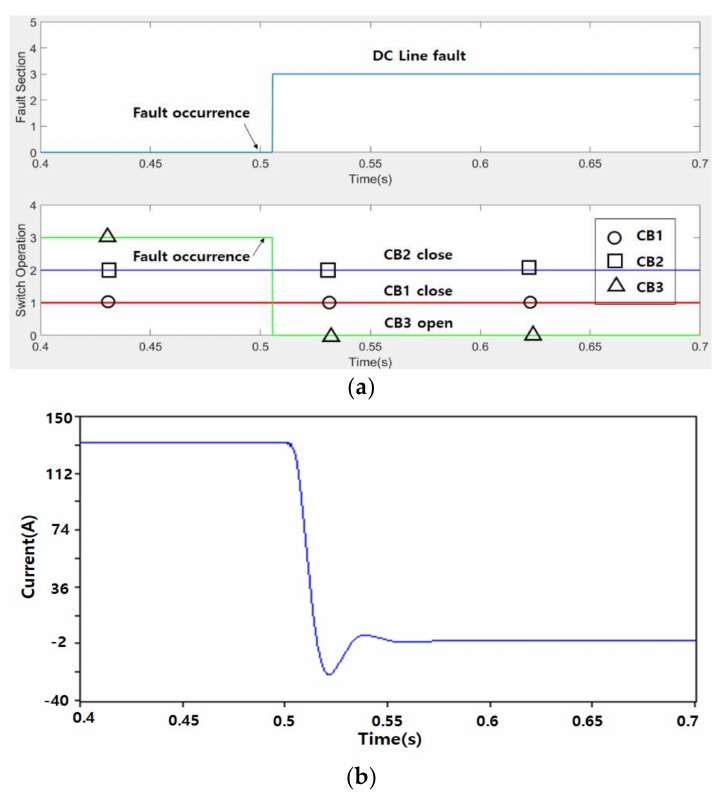
Figure 17. Simulation results of Case 5: ( a ) Fault section and CB operation and ( b ) Load current.